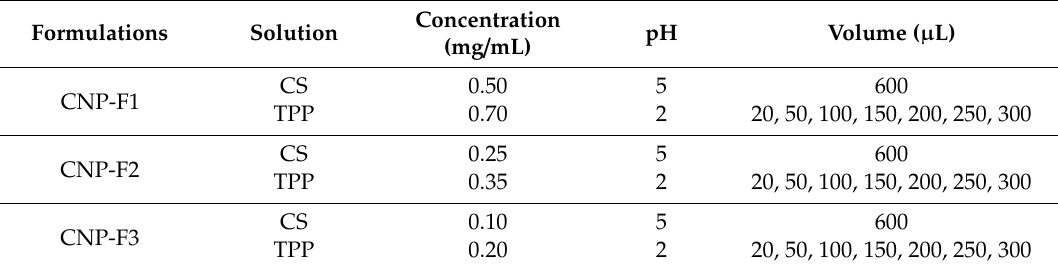
Table 1. Chitosan nanoparticles (CNP) synthesis based on three di ff erent formulations; CNP-F1, CNP-F2, and CNP-F3. Prior to formation of CNP, CS and TPP solutions were diluted to di ff erent concentrations and adjusted to pH 5 and pH 2, respectively. CNP were synthesized through ionic gelation interactions between a fixed volume of CS, 600 µ L and di ff erent volumes of